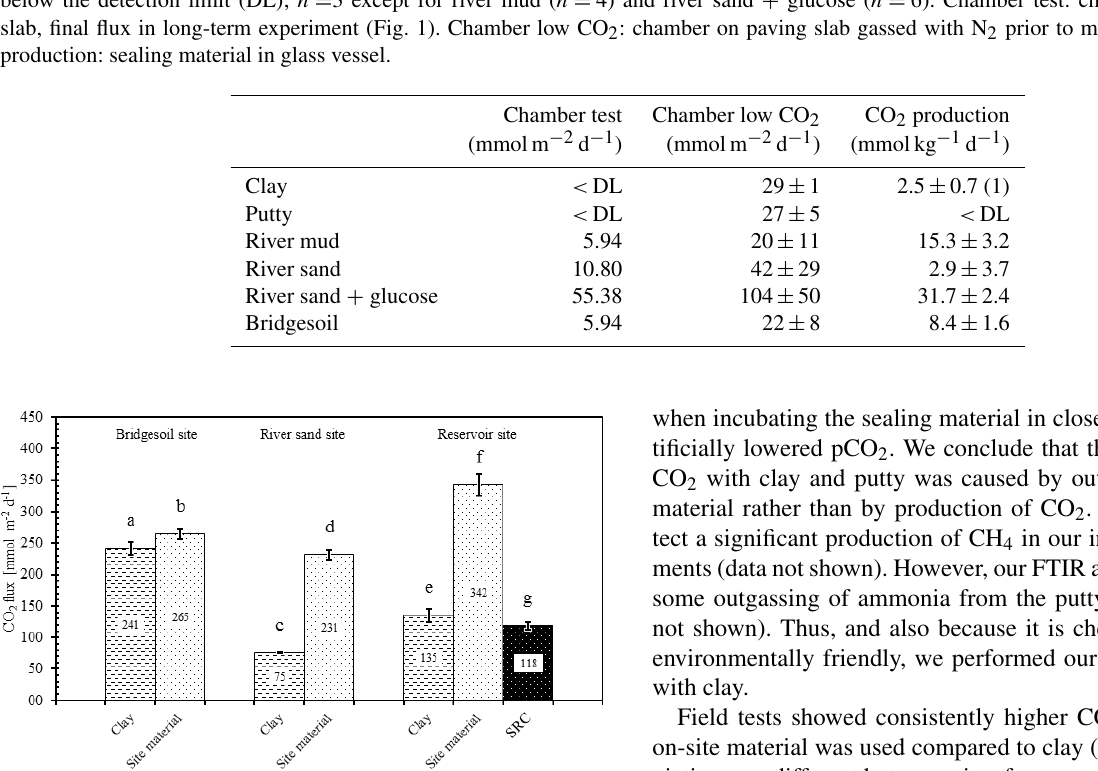
Figure 2. Mean CO 2 fluxes detected in the different sample groups during field experiments (mean ± SD, n = 3; reservoir site n = 4). SRC: soil respiration chamber + IR analyser. Different letters indi- cate significant difference between